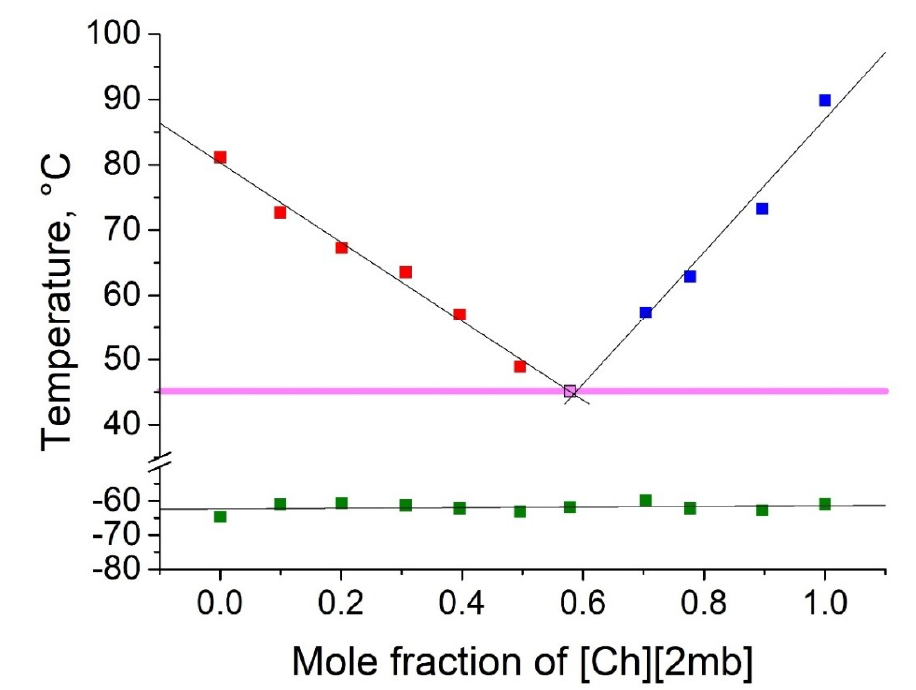
3 of 12 Figure 1. Temperature composition phase diagram for the mixture of choline acetate ([Ch][Ac]) and